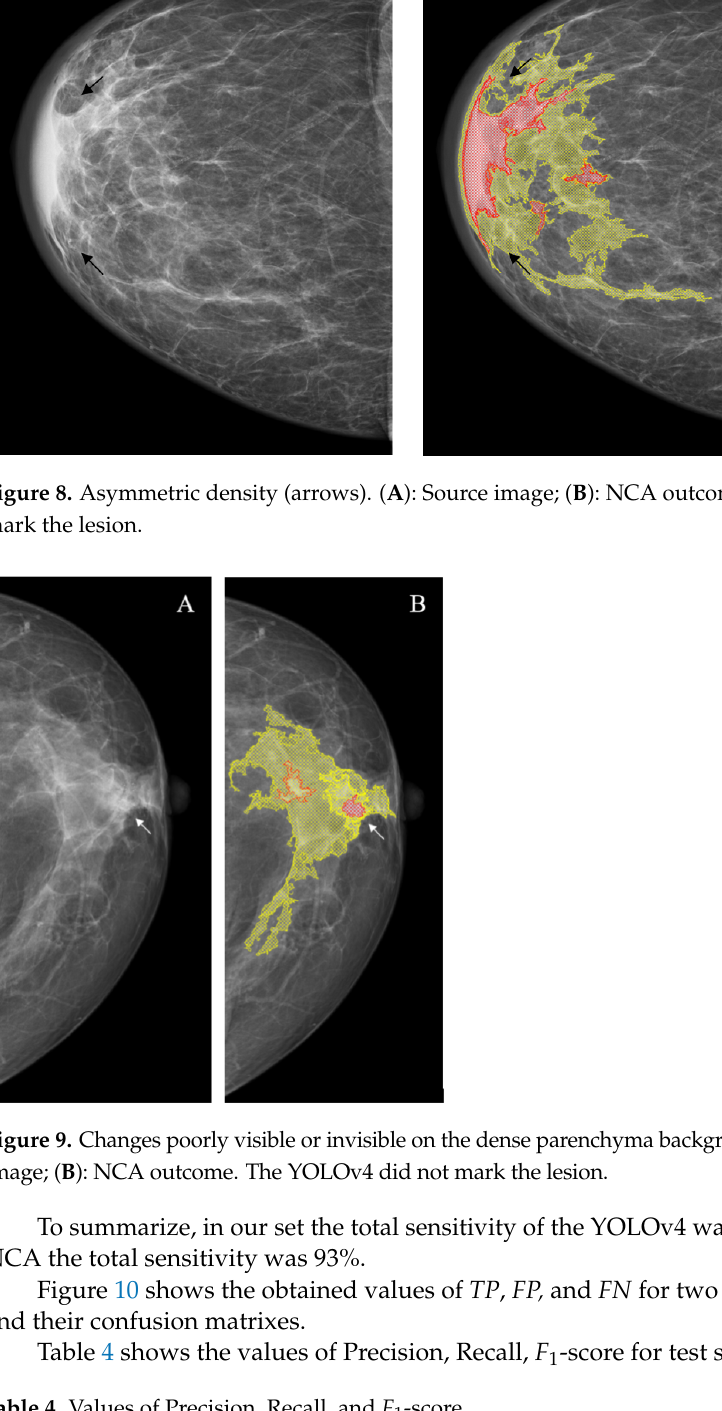
Table 4. Values of Precision, Recall, and F 1